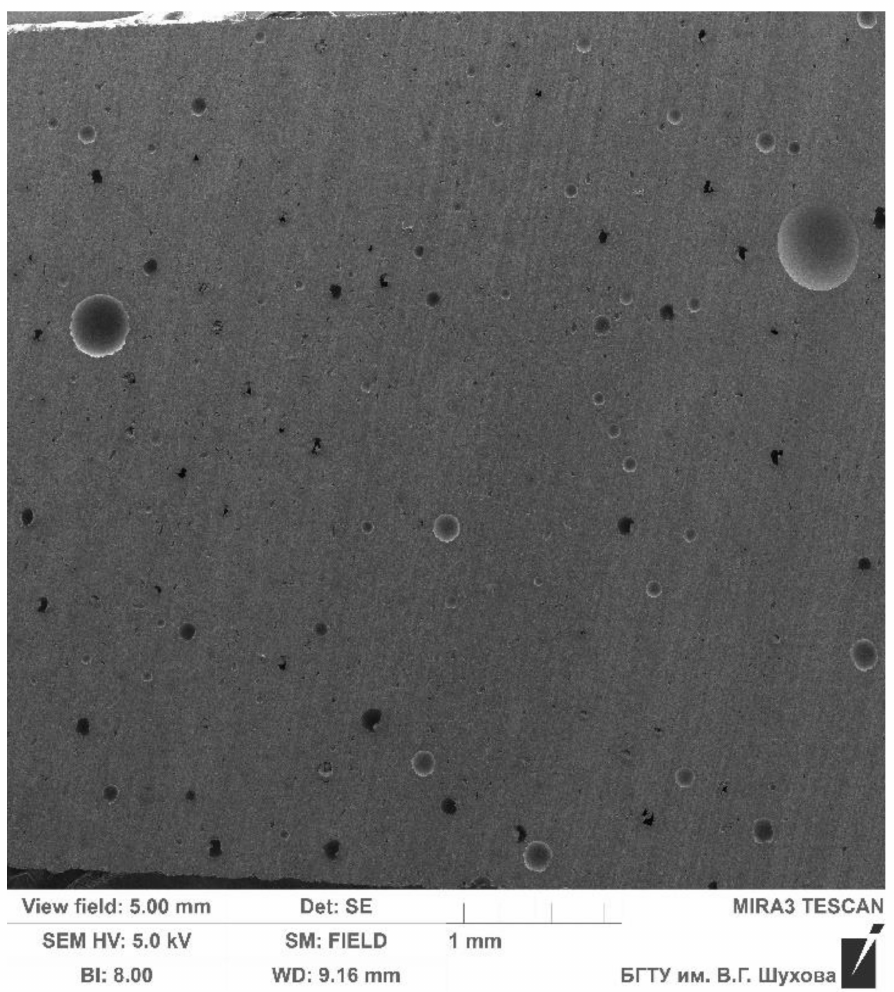
Figure 14. An enlarged cut of metal-polymer material “LEO filled with aluminum” cured at atmo- spheric